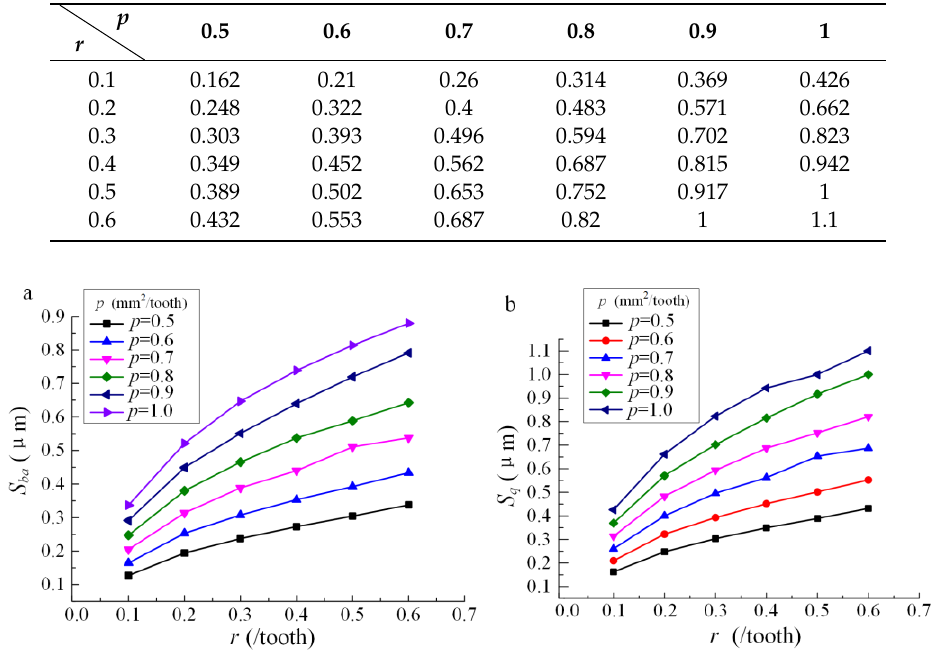
Table 4. S q (μm) for different values of p (mm 2 /tooth) and r (/tooth ). Table 4. S q ( µ m) for di ff erent values of p (mm 2 / tooth) and r ( / tooth).